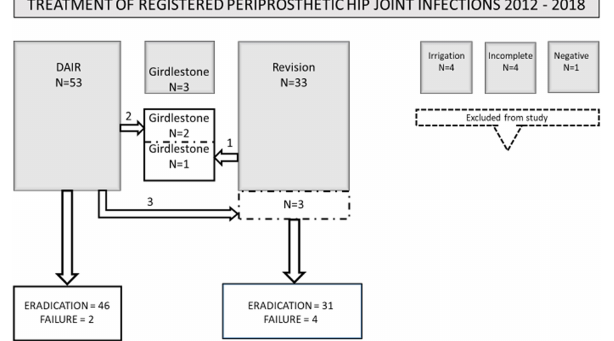
Figure 2. Presentation of all 89 total hip arthroplasties labeled periprosthetic joint infections (PJIs). Outcome of standardized treat- ment has been classified as “eradication” and